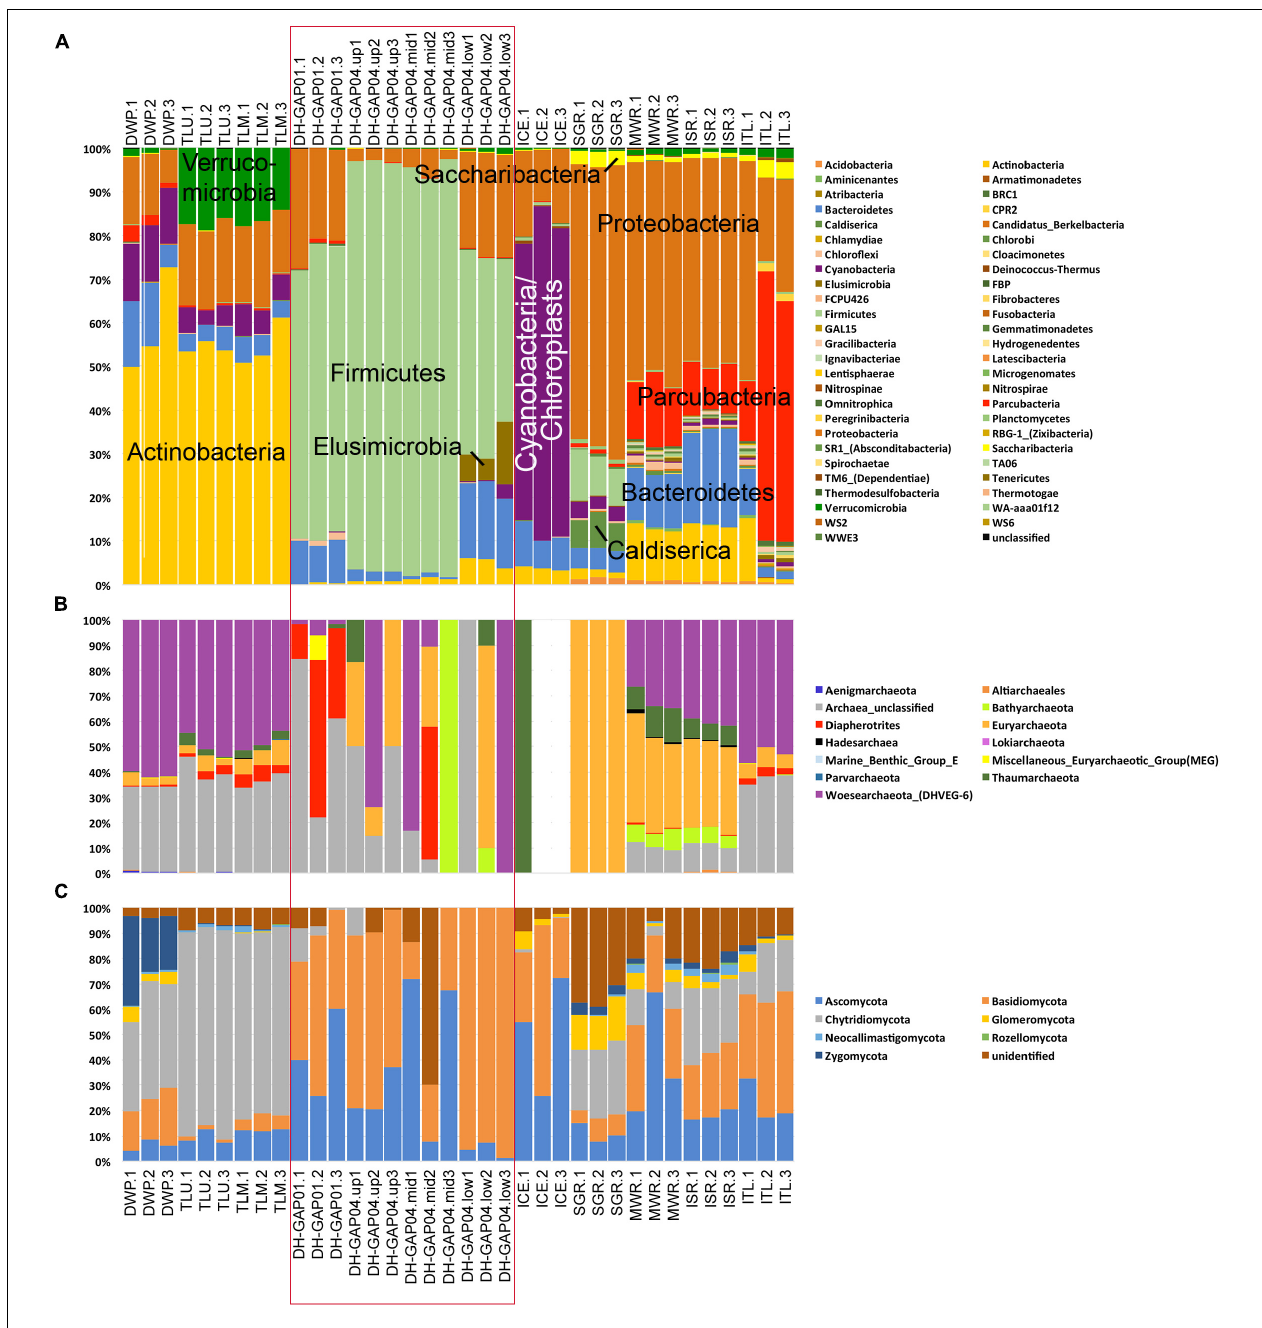
FIGURE 3 | The relative abundance of (A) bacterial, (B) archaeal, and (C) fungal phyla identified in the different samples. Note that each sampling site is represented by three biological replicates. The deep subsurface samples are indicated with a red rectangle, the pond/lake samples are presented to the left and the ice and melt water samples to the right of the rectangle for clarity. The bacteria with the highest relative abundances are indicated in A